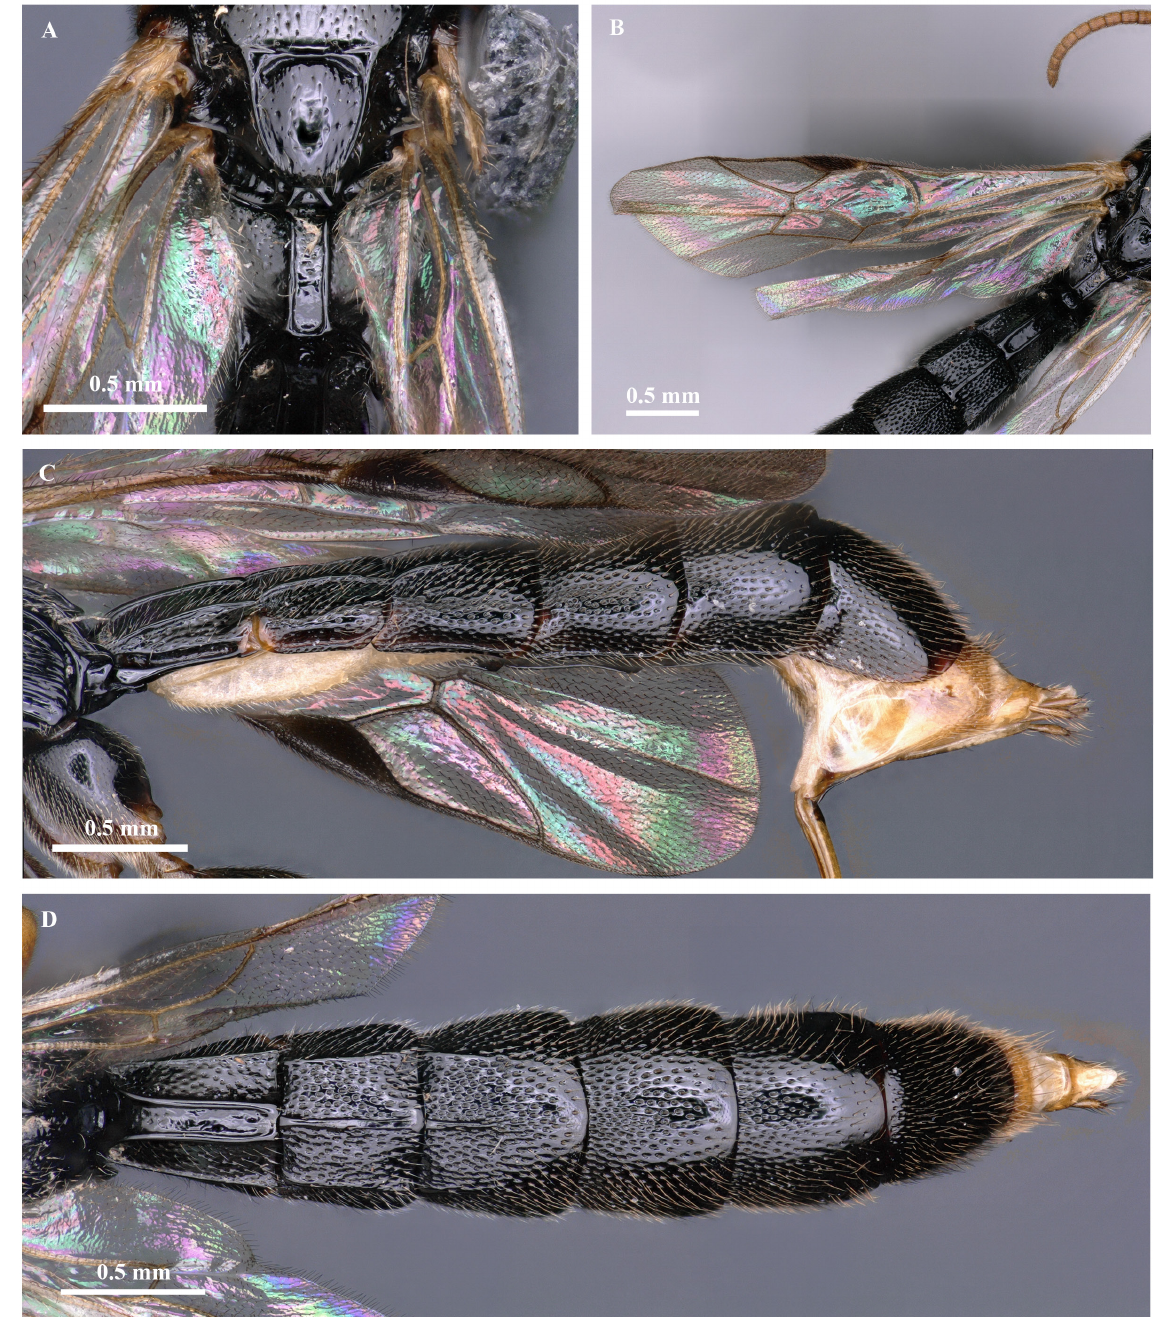
Fig. 2. Trieces irwini sp. nov., holotype, ♀ (AIMB). A . Propodeum, dorsal view. B . Fore wing. C . Metasoma, lateral view. D . Metasoma, dorsal